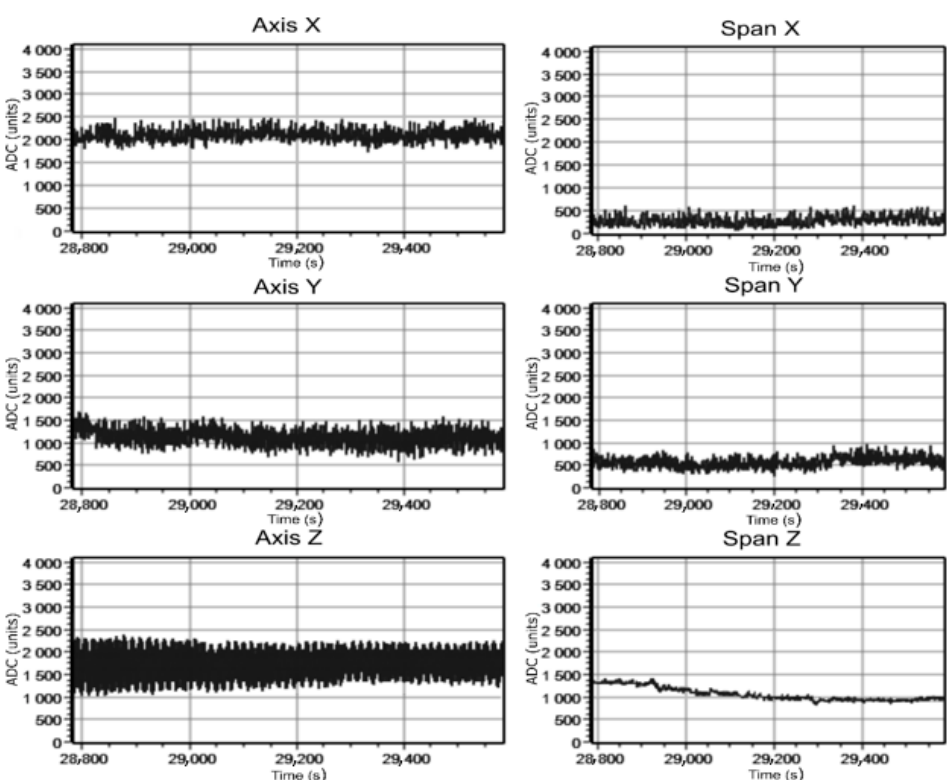
Figure 21. Change in signals at 65 A current in a cable during its rotation.